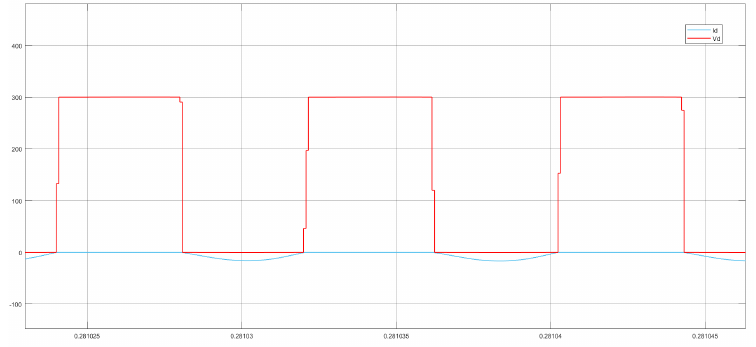
Figure 6. The primary side drive signal and the drain-source voltage and current waveforms of the switches.